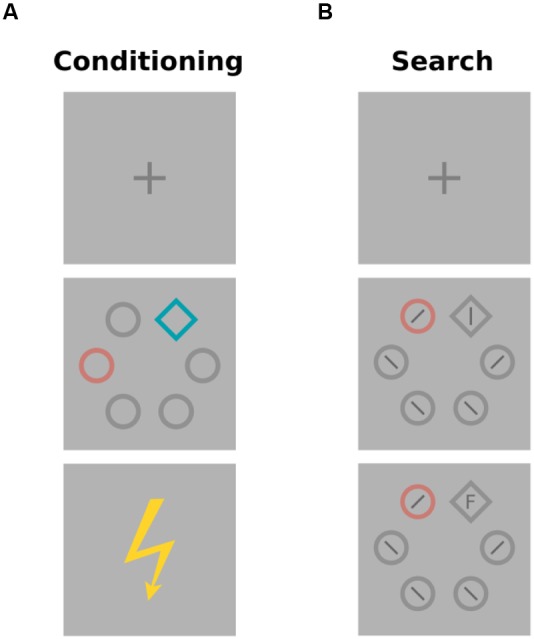
All trials started with a 2-s fixation cross. (A) In conditioning trials the subsequent search array was presented for 5 s and included a colored annulus and a colored diamond amongst gray distracter stimuli. Participants were instructed to attend to the color of the annulus in order to predict whether an electric shock was going to be delivered subsequently. (B) In search trials, previously trained colors were introduced as distracters to interfere with the required eye movement to a shape singleton (diamond).